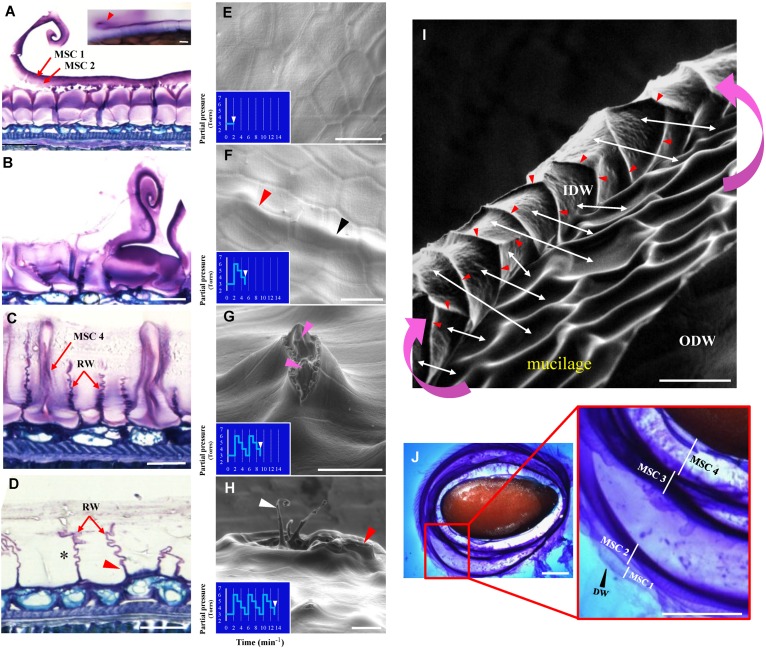
Flax seed mucilage release involves a peeling mechanism. (A–D) Cytological analysis of mature flax seed coat sections from RIL 44 stained with toluidine blue O 0.01% 24 h after imbibition. According to the degree of imbibition, each step of the mucilage release process can be observed. (A) Beginning of distal wall breaking and peeling. Picture in the top right corner shows the same pattern when whole seeds are soaked in water (red arrowhead). Note that MSC 1 and 2 (red arrows) are secreted along with the distal wall. (B) Advanced stage of the peeling process. (C) MSC 4 is being released. (D) Empty MSCs. Asterisk shows the “accordion” pattern of the radial cell walls. (E–I) Environmental scanning electron microscopy (ESEM) analysis of the mucilage release process submitted to successive increase/decrease water partial pressure steps. (E) Flax MSCs surface prior to water imbibition. (F) Characteristic profile of the flax MSCs surface after the first increase/decrease water partial pressure step. Domed surfaces can be observed both at the cell-to-cell junctions and in the middle of the cells (red and black arrowheads, respectively). (G) The second step enables the mucilage cell surface to break. Pink arrowheads show the mucilage polysaccharides. (H) The third step enables the fault to extend to neighboring cells and their distal cell walls to peel together. White arrow indicates the same peeling structures as observed in (A) and red arrow the same structure as observed in (I) from a different view angle. (I) SEM micrograph of the flax MSC peeling mechanism. Pink curved arrows show the direction of the peeling mechanism. White arrows indicate for some selected MSCs matches between the inner surfaces of their distal wall (IDW) and the inside of the MSCs. Red arrowheads show domed structures that delimit each MSC and correspond to the upper part of the radial walls. (J) The classical pattern of successive mucilage polysaccharides layers observed when mature flax seeds are soaked in water containing toluidine blue O 0.01%. IDW, inner surface of the distal primary cell wall; ODW, outer surface of the distal primary cell wall; RW, radial cell wall. Bars = 20 μm (A–I) and 1 mm (J).